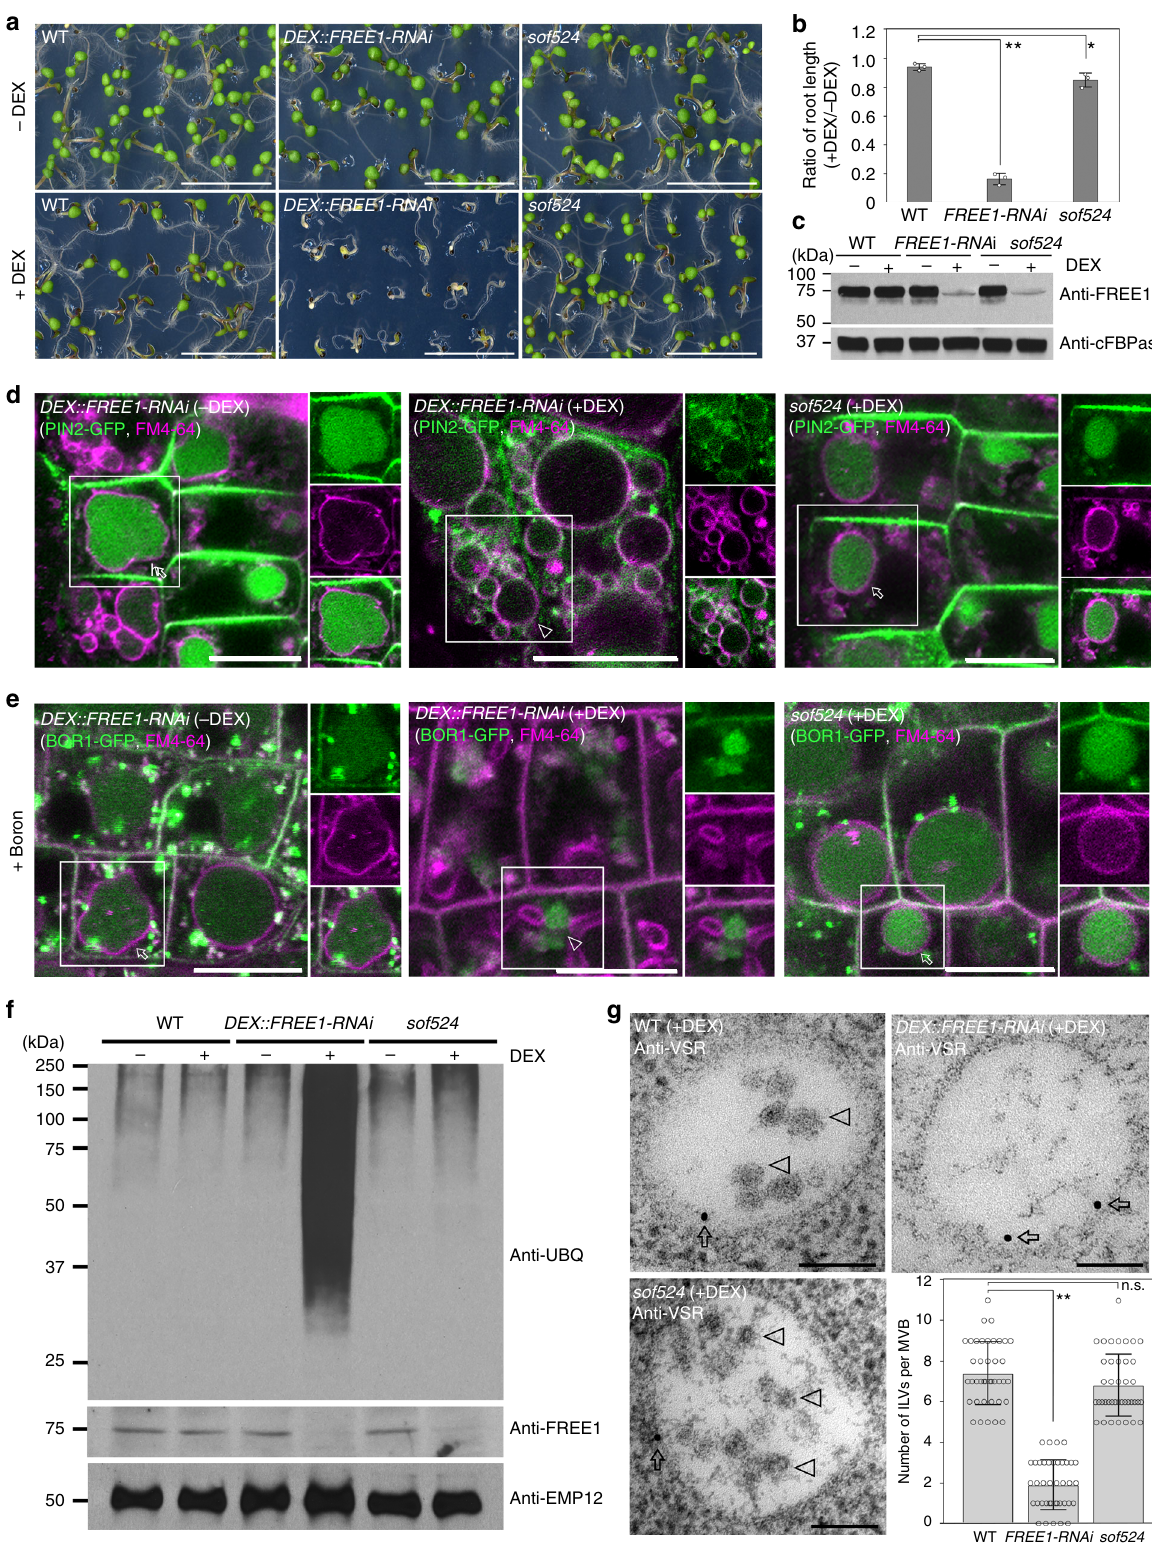
under DEX. A statistical analysis of the VSR antibody-labeled MVBs/PVCs further supports our speculation that the sof524 mutant restored the integrity of ILVs in MVBs (Fig. 1g), which fi nally recovered ubiquitinated membrane cargo for vacuolar degradation. Moreover, cell biological analysis further revealed